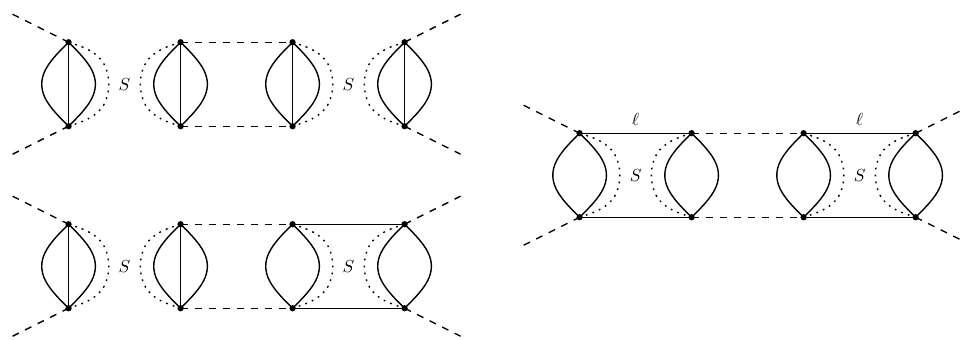
(left) and (cid:12) S (right). Here, the dashed 0 1